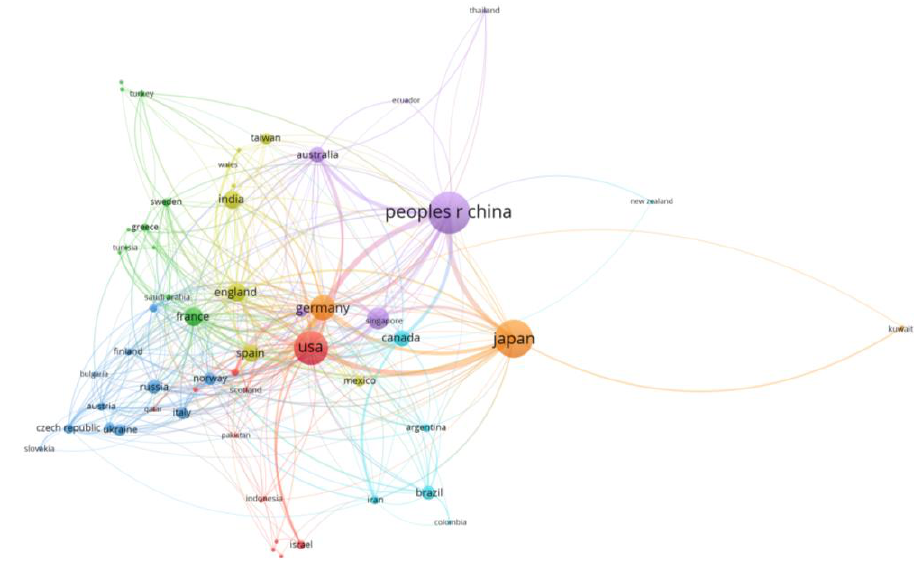
Figure 3. Cooperation network for main countries ’ research on hydrogen embrittlement.